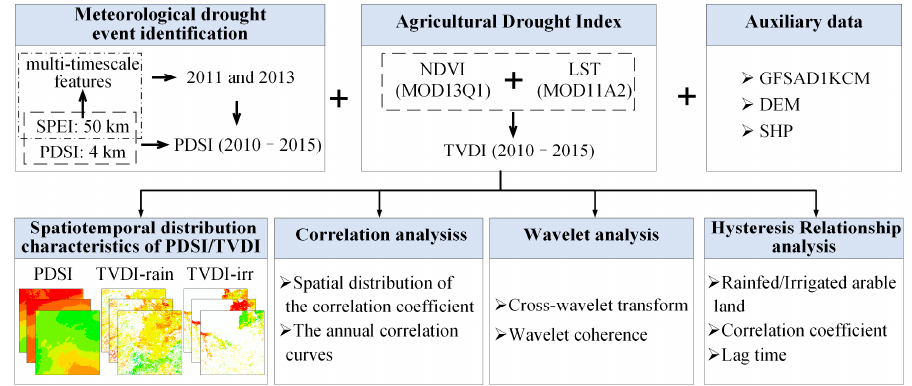
Figure 2. The flow chart of the methodology. SPEI: Standardized Precipitation Evapotranspiration Index. PDSI: Palmer Drought Severity Index. TVDI: Temperature Vegetation Drought Index. TVDI-rain/irr: TVDI of rainfed/irrigated arable land. MOD13Q1/MOD11A2: The satellite data. GFSAD1KCM: Global Food Security support Analysis Data.